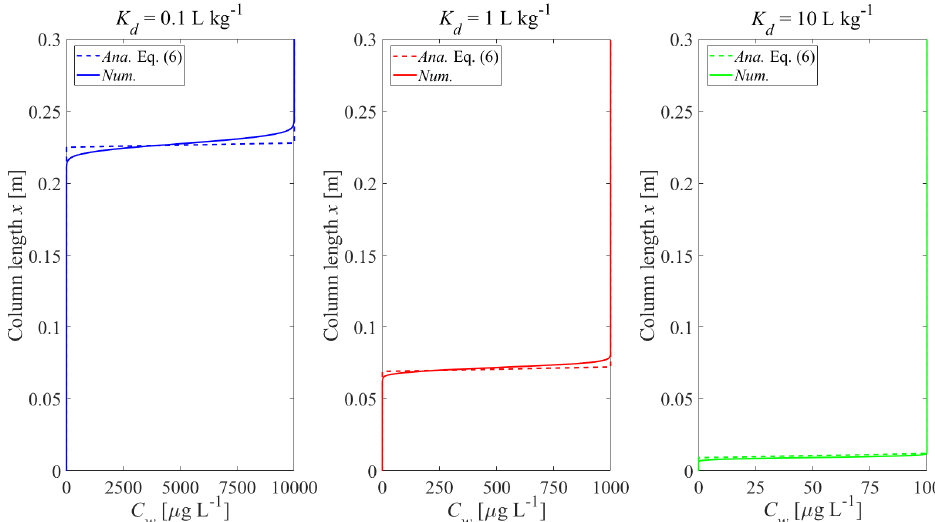
Figure A3. Concentration vs. distance in the up-flow column test after the first flooding of the column (initial condition). Comparison of the analytical solution (Equation (6), dashed lines) and numerical solution (solid lines); n = 0.45, v = 1.67 × 10 − 5 m s − 1 , α = 0 (no dispersion), C s , ini = 1000 µ g kg − 1 , t c = 5 h, d p , fine = 63 µ m.